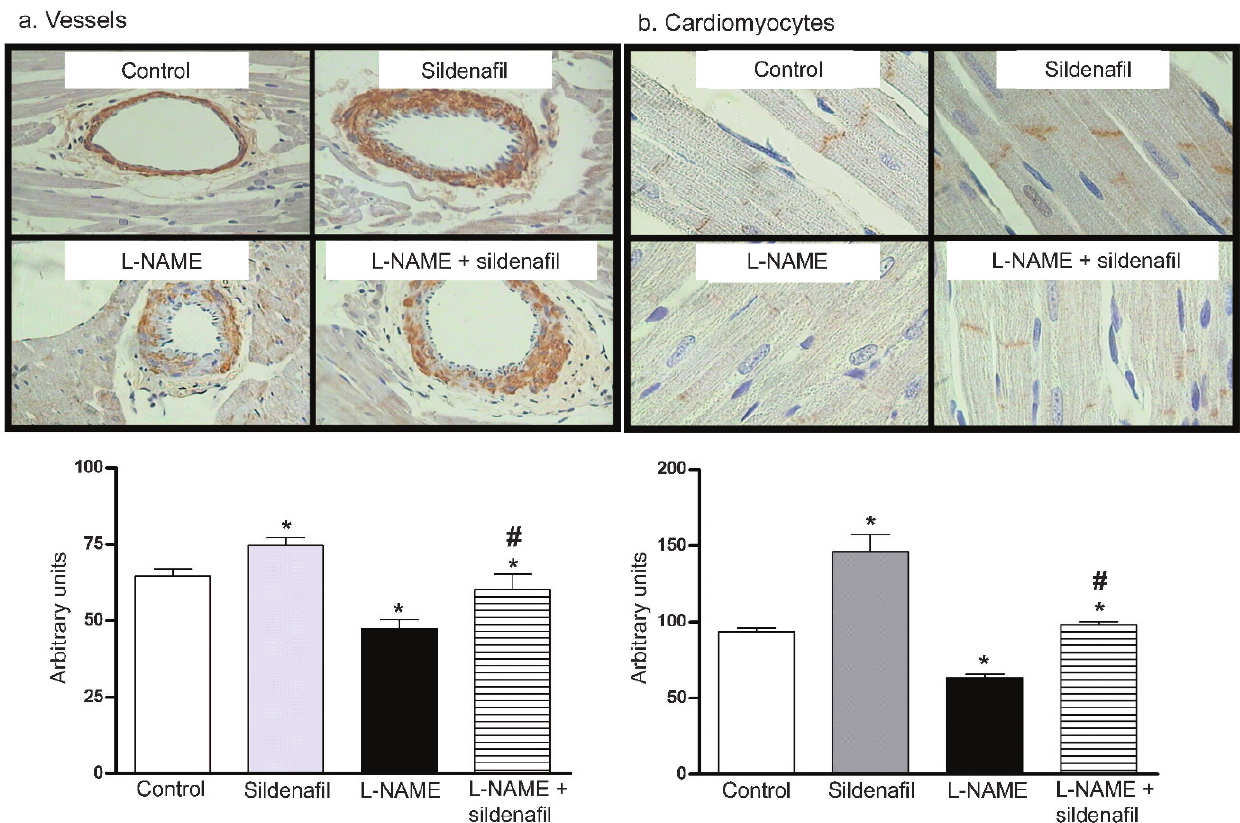
Figure 2 - A) The PDE5 immunohistochemistry in the cardiac arteries after 8 weeks of treatment. Representative photomicrographs and a summary graph of the quantitative analysis of the staining intensity in the vascular smooth muscle cells of small arteries are shown. B) The PDE5 immunohistochemistry in the cardiac tissue after 8 weeks of treatment. Representative photomicrographs and a summary graph of the quantitative analysis of staining intensity in the intercalary discs between myocytes. The data are expressed in arbitrary units; n=5/group; * p , 0.05 vs. control; # p , 0.05 vs. L-NAME.